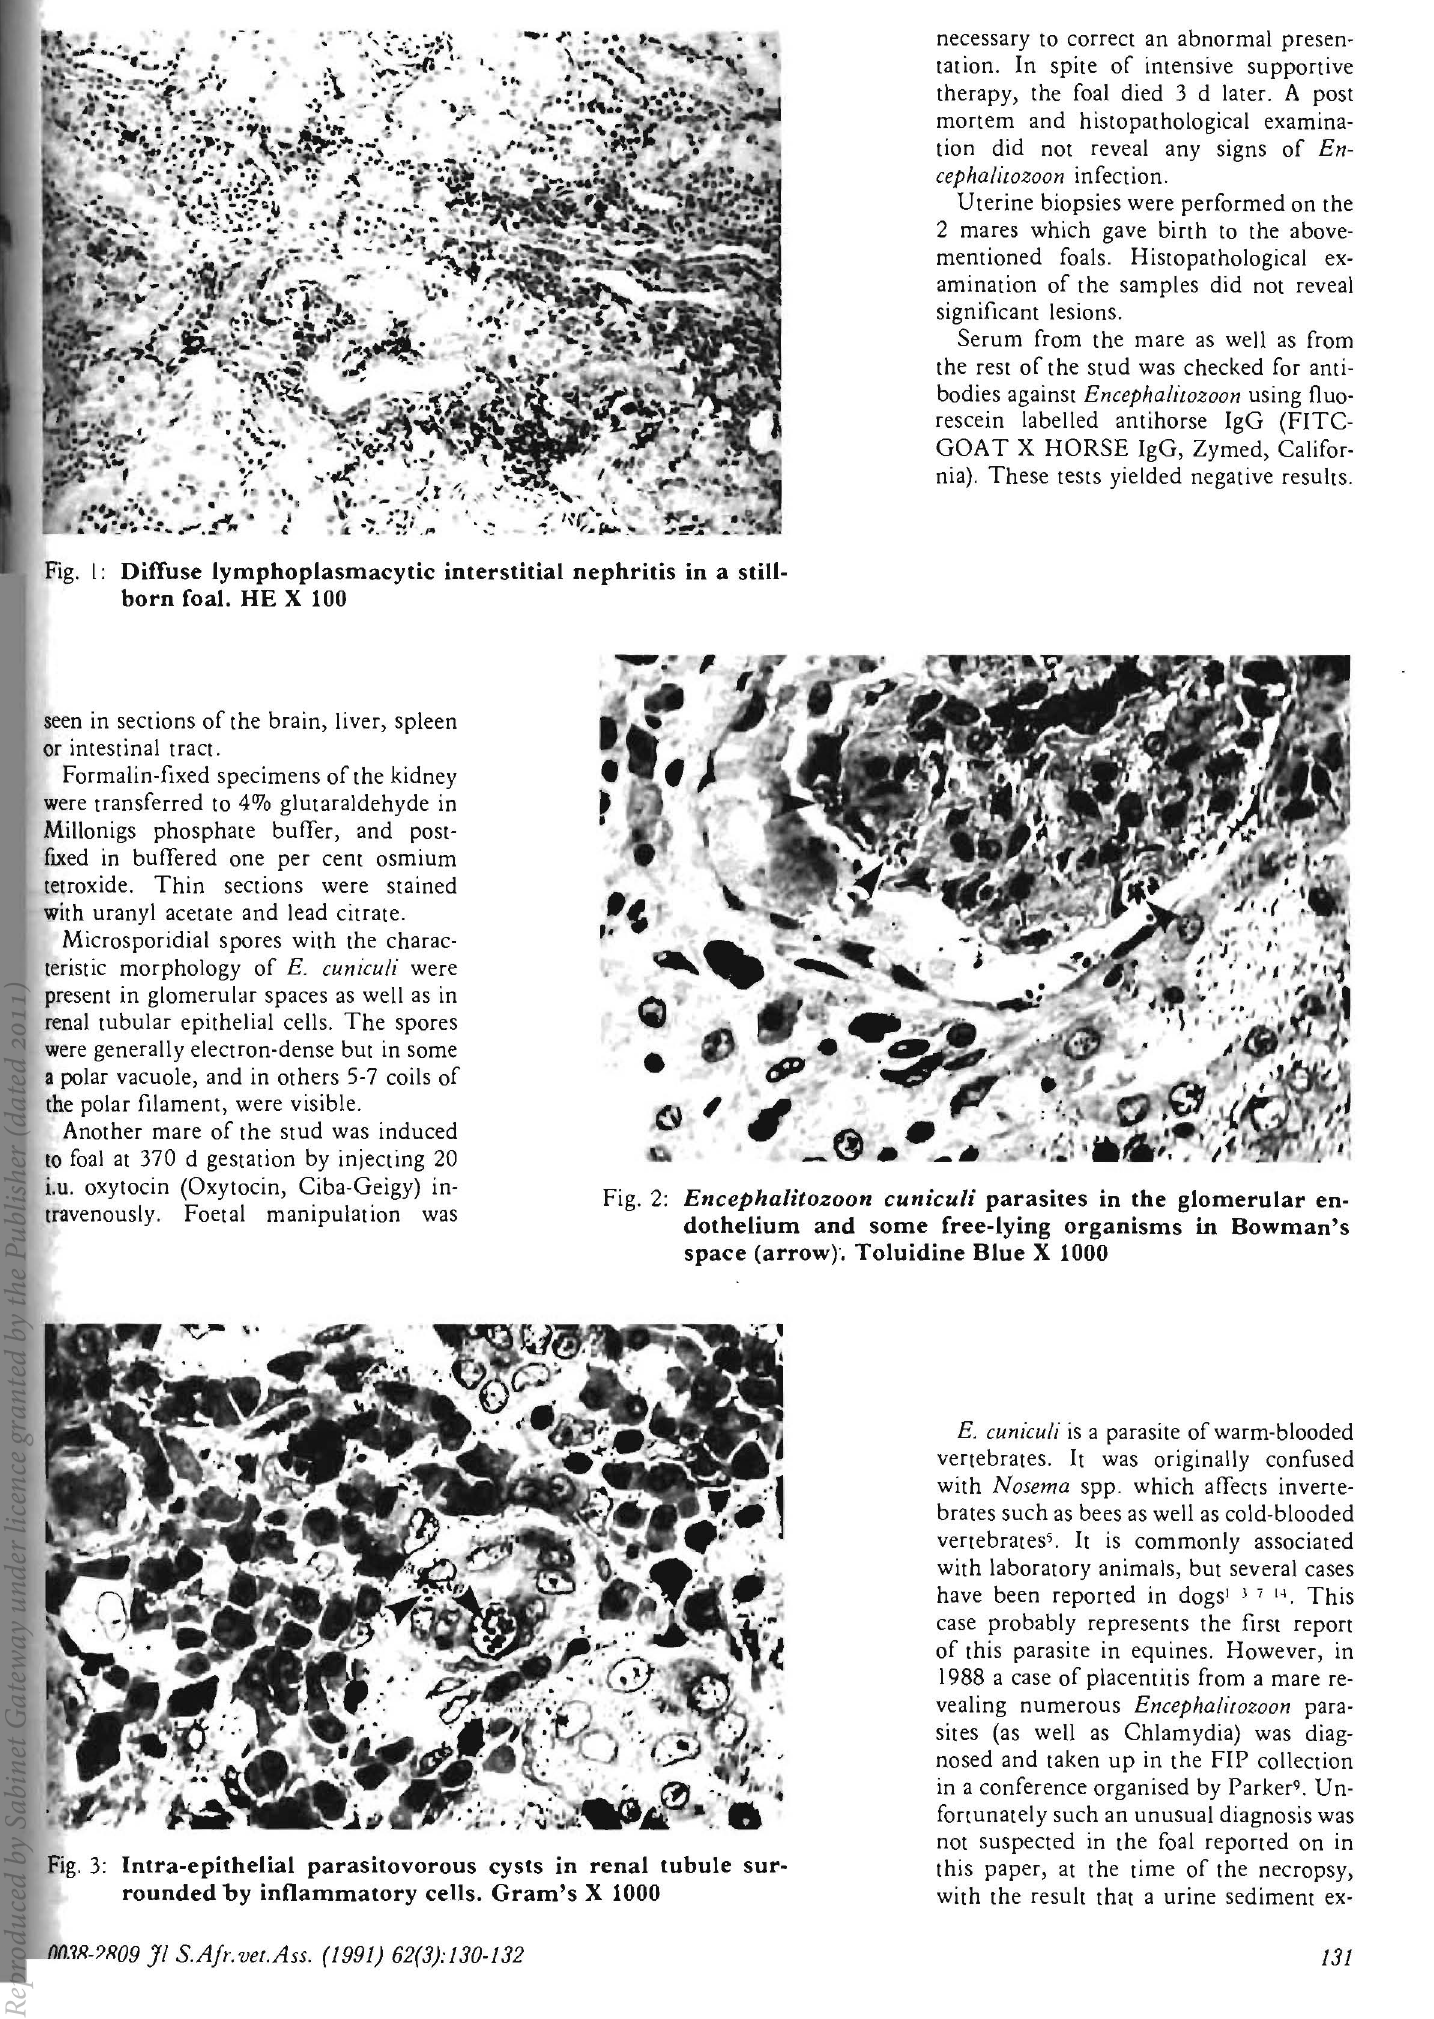
Fig. 3: Intra-epithelial parasitovorous cysts in renal tubule sur rounded by inflammatory cells, Gram's X 1000 M.1R-?R09 JI S.A/r.ver.Ass. (1991)